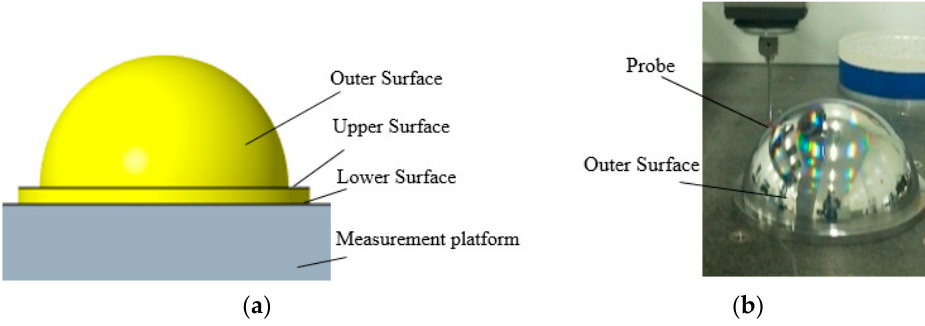
Figure 8. The outer surface measurement: ( a ) the measurement model; ( b ) measuring the real object.